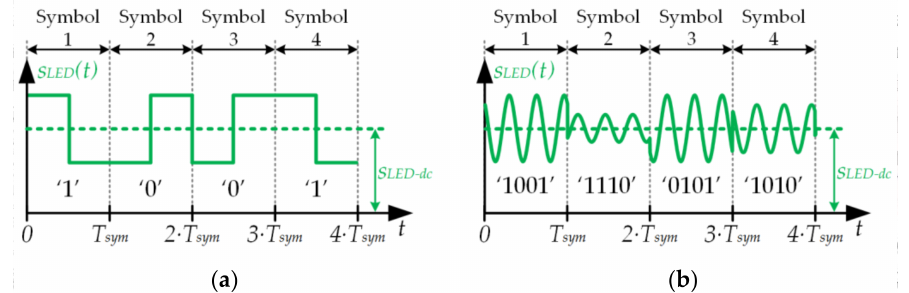
Figure 1. Two modulating strategies for visible light communication (VLC): ( a ) Example of a pulse modulation sequence: four symbols of a pulse position modulation (PPM) scheme; ( b ) Example of a pass-band modulation sequence: four symbols of a 16-quadrature amplitude modulation